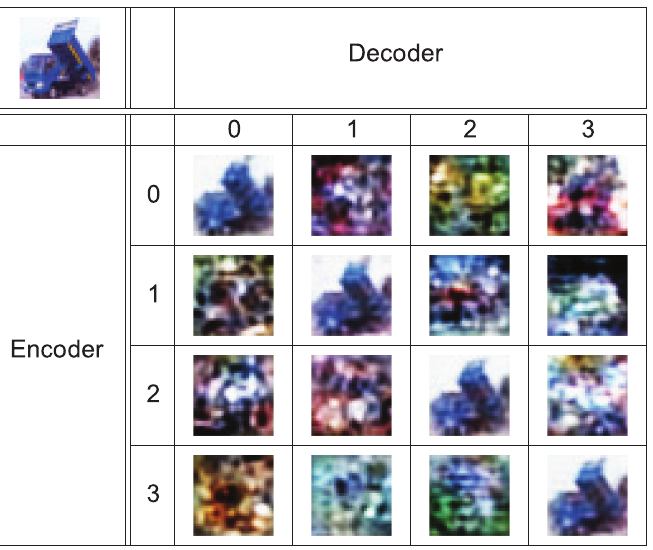
Fig 8. Combinations of (encoder, decoder) pairs from various instances. Results of dec image x is shown in upper left corner. The x is properly recreated only if i == j .